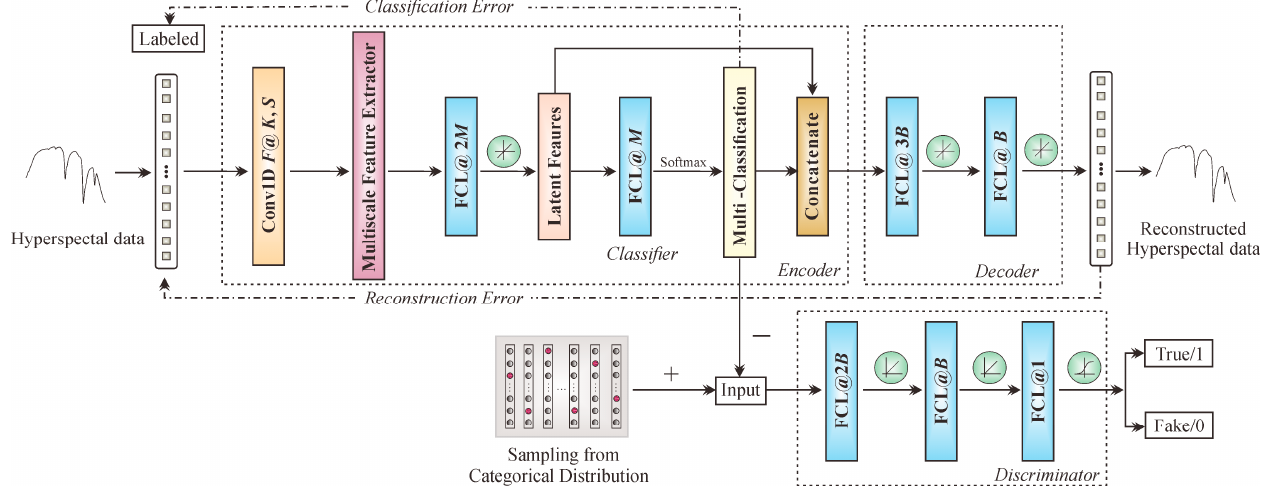
Figure 3. The SSAAE architecture for classification of alteration zones using drilling core hyperspec- tral data. The classifier is trained on datasets given a labeled mini-batch and mostly unlabeled while the multi-classification representation is imposed on a Categorical distribution using an adversarial process. Where Conv1D F @ K , S represents a 1D convolutional layer with a filter size of F , kernel size of K , and stride of S , and FCL@ m denotes an FCL with the output dimension of m